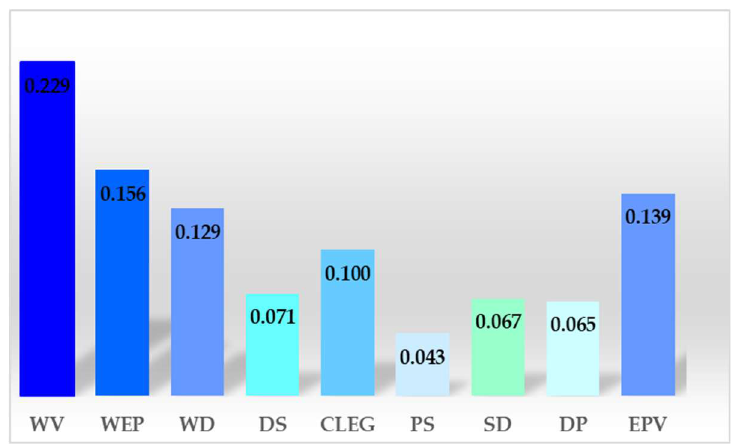
Figure 4. Relative weights of evaluation criteria with respect to the goal (Level II).